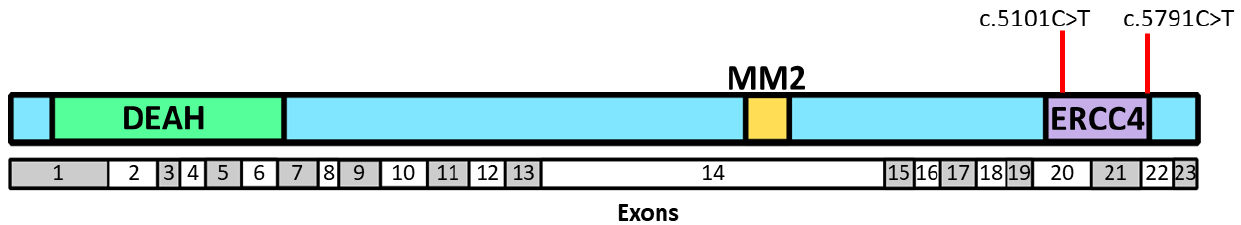
Figure 3. Schematic illustration of FANCM domains and rs147021911 (c.5101C>T) and rs144567652 (c.5791C>T) localization.